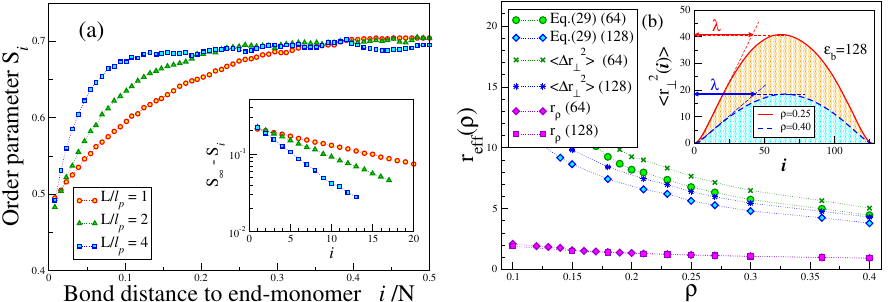
Figure 5. ( a ) Local order parameter S i that describes the orientation of the bond connecting monomers at r i and r i + 1 (the free ends being i = 1 and i = N , and all equivalent bonds in the system are averaged over) plotted versus i / N for N = 128, the total number of monomers being N N = 460,800, for three choices of (cid:101) b : (cid:101) b / k B T = 128, ρ = 0.1; (cid:101) b / k N T = 64, ρ = 0.16; (cid:101) b / k B T = 32, ρ = 0.25. The densities were chosen such that the nematic order parameter S is close to 0.7 in each case. The three choices of the parameter N / (cid:101) b (which roughly corresponds to L / (cid:96) p ) are indicated in the key. The inset shows a semi-log plot of S ∞ - S i vs. i to test Equation (31). The resulting values of λ are 8.2, 3.65 and 2.36, respectively; ( b ) Effective cylinder radius r eff plotted vs. density ρ , for N = 128, and two choices of (cid:101) b : (cid:101) b = 64 and 128, as indicated in the key. Furthermore, the radius r ρ (Equation (27); cf. Figure 4c) is included for comparison. The inset shows a plot of the transverse mean-square displacements (cid:104) r 2 ⊥ ( i ) (cid:105) , relative to the end-to-end vector of the chain, as a function of i , for (cid:101) b = 128 at two densities, as indicated. Equation (28) implies that (cid:104) r 2 ⊥ ( i ) (cid:105) increases linearly with i and saturates at i ≈ λ with (cid:104) r 2 ⊥ ( i ) (cid:105) ≈ ( r eff / λ ) 2 . The data points for r eff are extracted from these maximum transverse displacements, and the estimates extracted from Equation (29) are included for comparison. Reproduced from [43] with permission from the Royal Society of